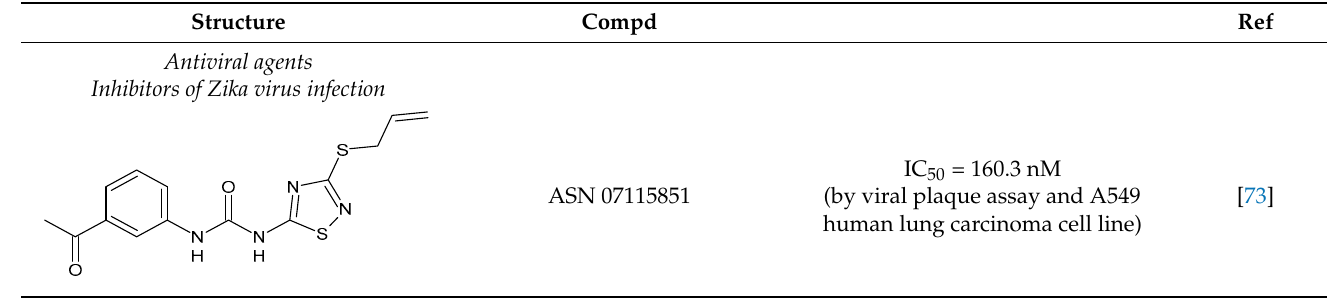
Table 3. Diarylureas as antiviral and antimalarial agents.